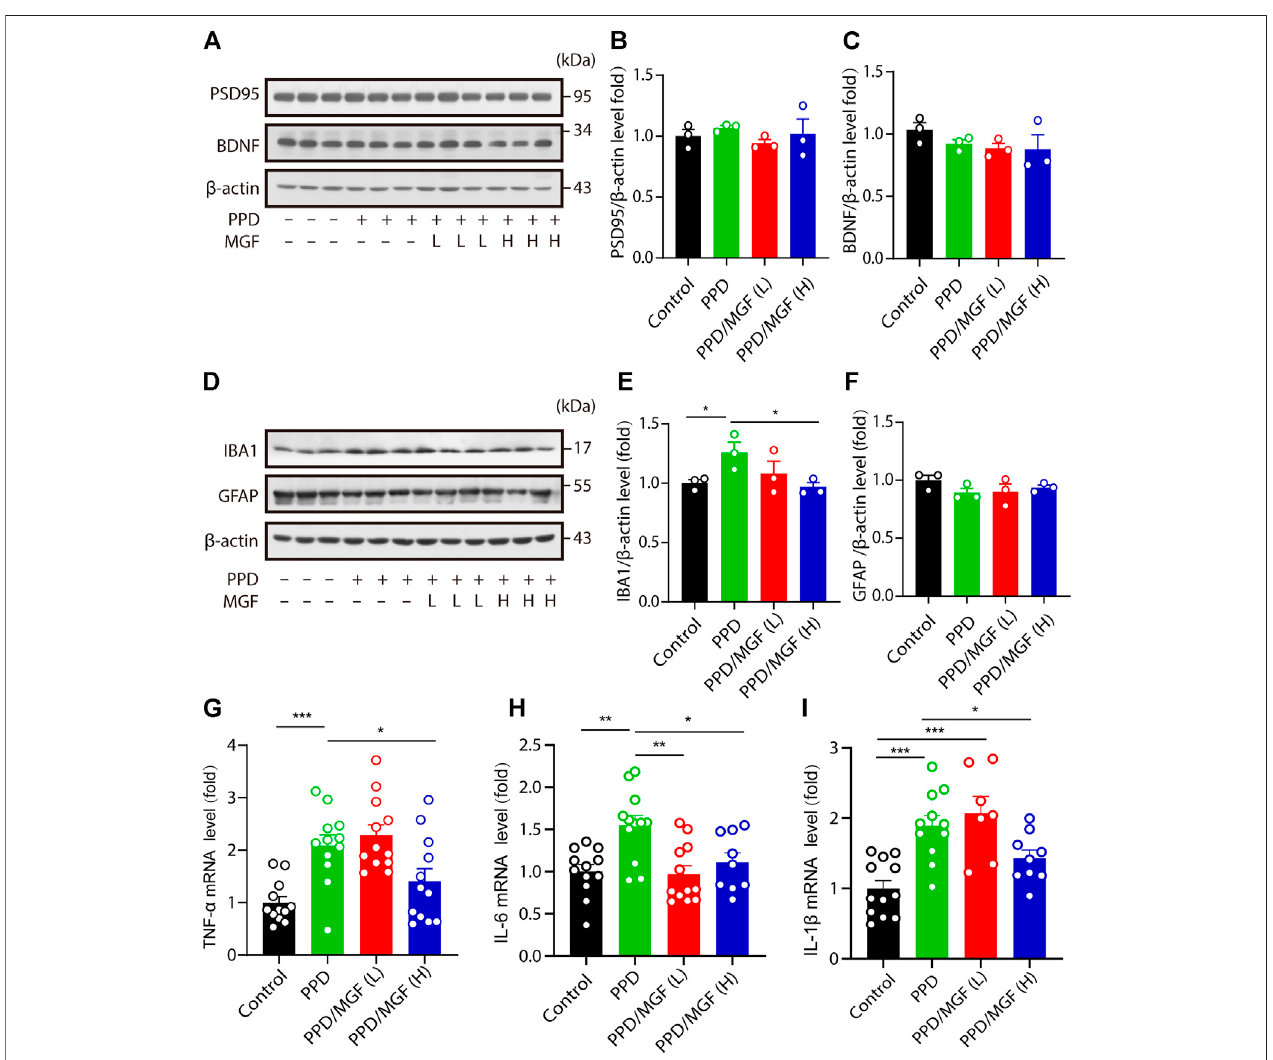
FIGURE 3 | MGF decreased in fl ammatory cytokine levels in the mouse brain. (A – C) Immunoblotting and quantitative analysis of plasticity-related protein 95 (PSD95) and brain-derived neurotrophic factor (BDNF) levels in the hippocampus of mice. (D – F) Immunoblotting and quantitative analysis of IBA1 and GFAP protein levels in the cortex of the indicated-group mice. (G – I) RT-PCR analysis of TNF- α , IL-6, and IL-1 β mRNA levels in the hippocampus of mice. Error bars are mean ± SEM. * p < 0.05, ** p < 0.01, and *** p < 0.001.